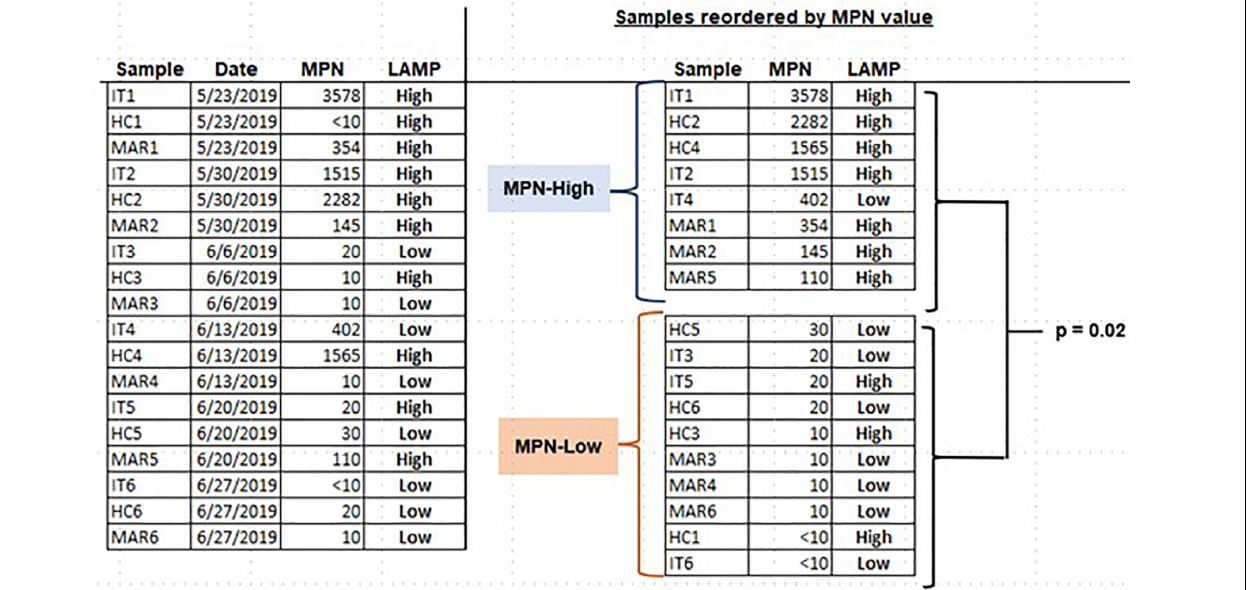
Frontiers in Microbiology |